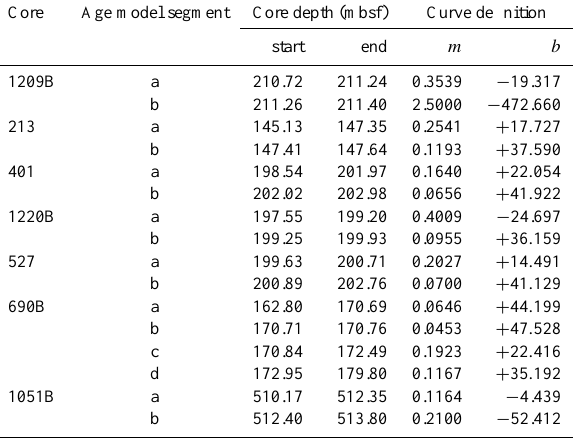
Table 2. Age models.